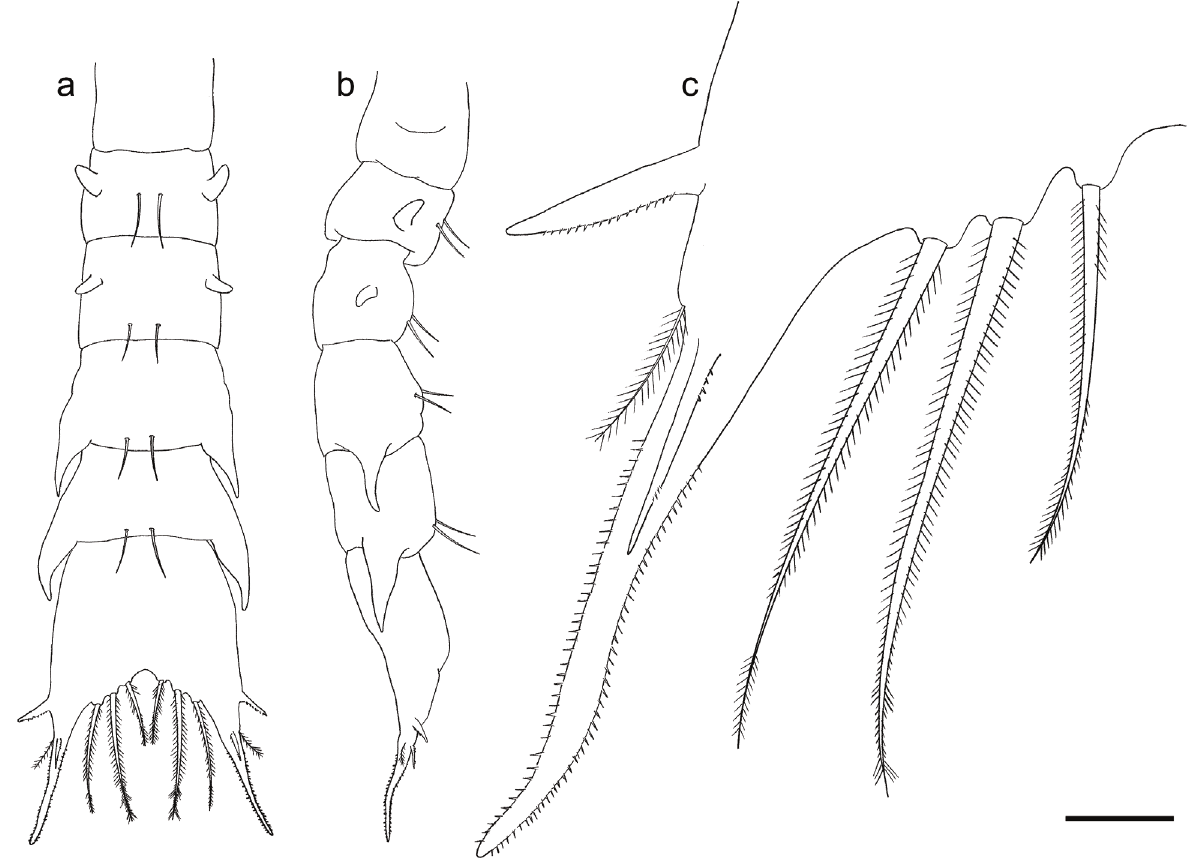
Figure 3. Domecia acanthophora (Desbonne, in Desbonne & Schramm, 1867), Zoea I. a. Pleon, dorsal view; b. Pleon, lateral view; c. Detail of spinulation of the telson furcae (scale bars: a, b = 0.1 mm; c = 0.02 mm). dorsal spinules; second pair smaller, smooth, slightly curved ventrally; third pair smallest and smooth near carapace margin. Sessile